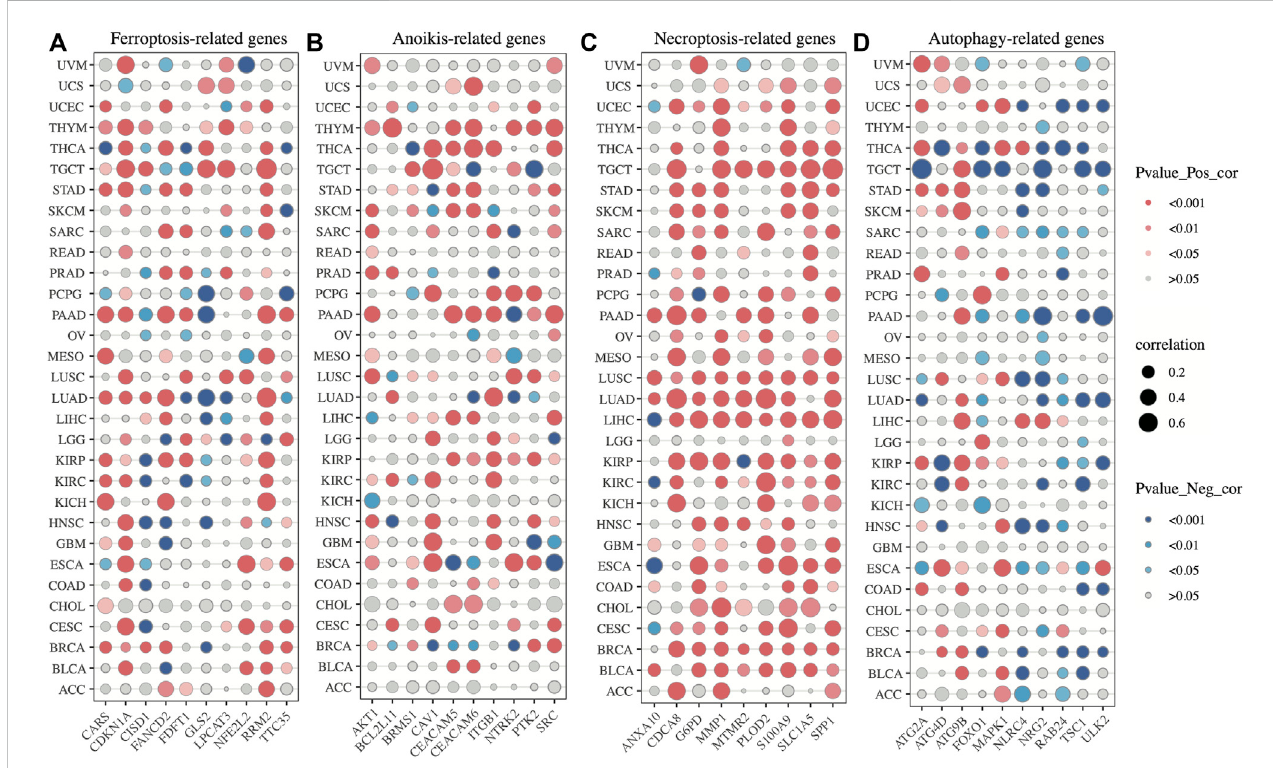
FIGURE 14 CorrelationanalysisbetweenSLC2A1andprogrammedcelldeath-relatedgenes (A) SLC2A1wascorrelatedwithferroptosis-relatedgenesinpan-cancer (B) SLC2A1wascorrelatedwithanoikis-relatedgenesinpan-cancer (C) SLC2A1wascorrelatedwithnecroptosis-relatedgenesinpan-cancer (D) SLC2A1was correlated with autophagy-related genes in